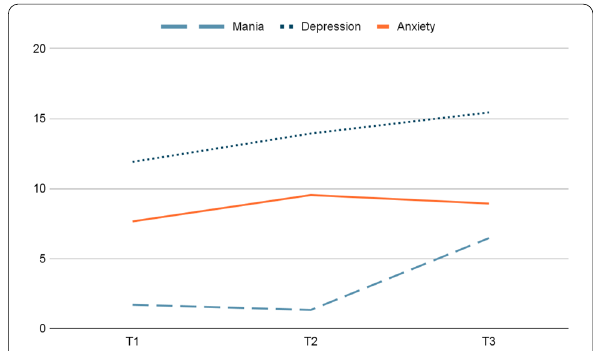
Fig. 2 The course of psychiatric symptoms during the COVID-19 pandemic at T1, T2 and T3. T1 T3 September 2020. Depressive symptoms T1 = Anxiety symptoms T1 < T2, T2